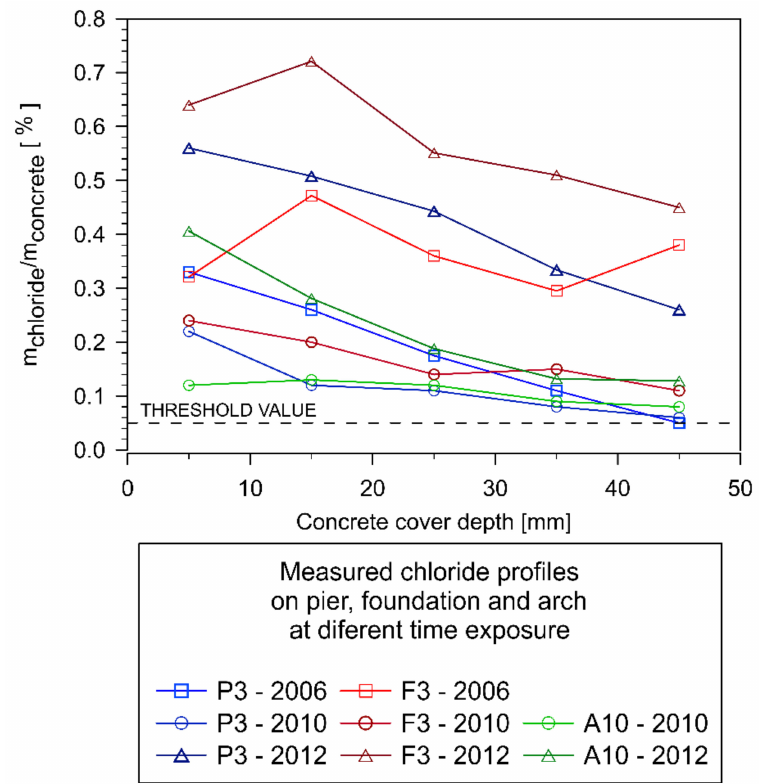
Figure 5. Measured chloride profile on pier P3 (15 m above sea level, surface exposed to NNE), joint pier P3 and arch foundation F3 (10 m above sea level, surface exposed to ENE), and arch segment close to the arch foundation at pier P10 (10 m above sea level, surface exposed to ENE) in different time periods: 2006, 2010 and